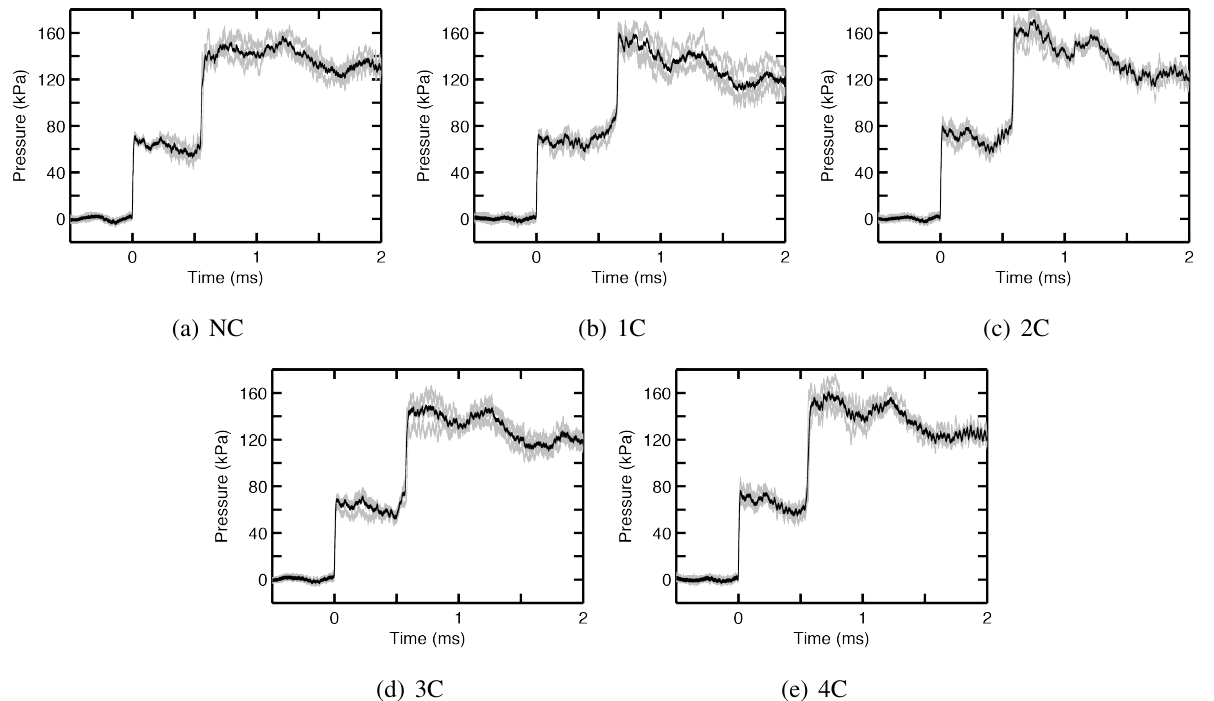
Figure A6. Closed cell foam pressure recordings for all cases: incident and reflected shock.